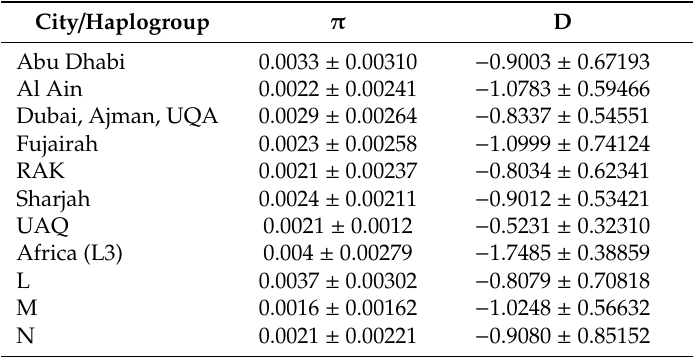
Table 3. Population genetic parameters per cities and